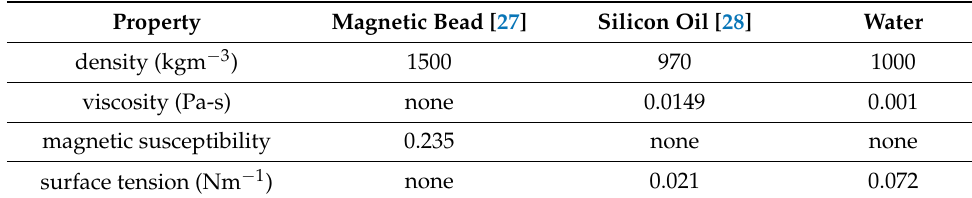
Table 3. Properties of